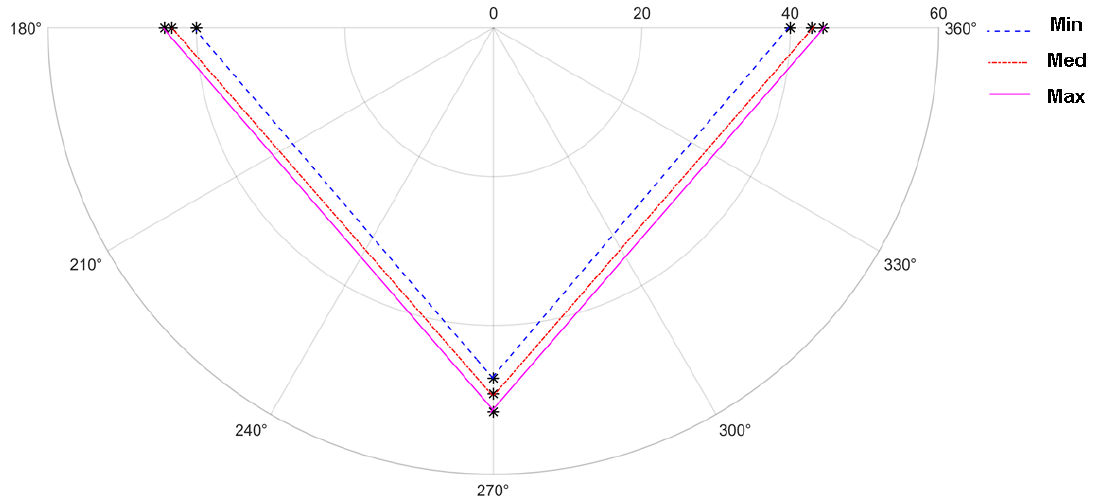
Table 1. Sound pressure level (dB Lin) measured.